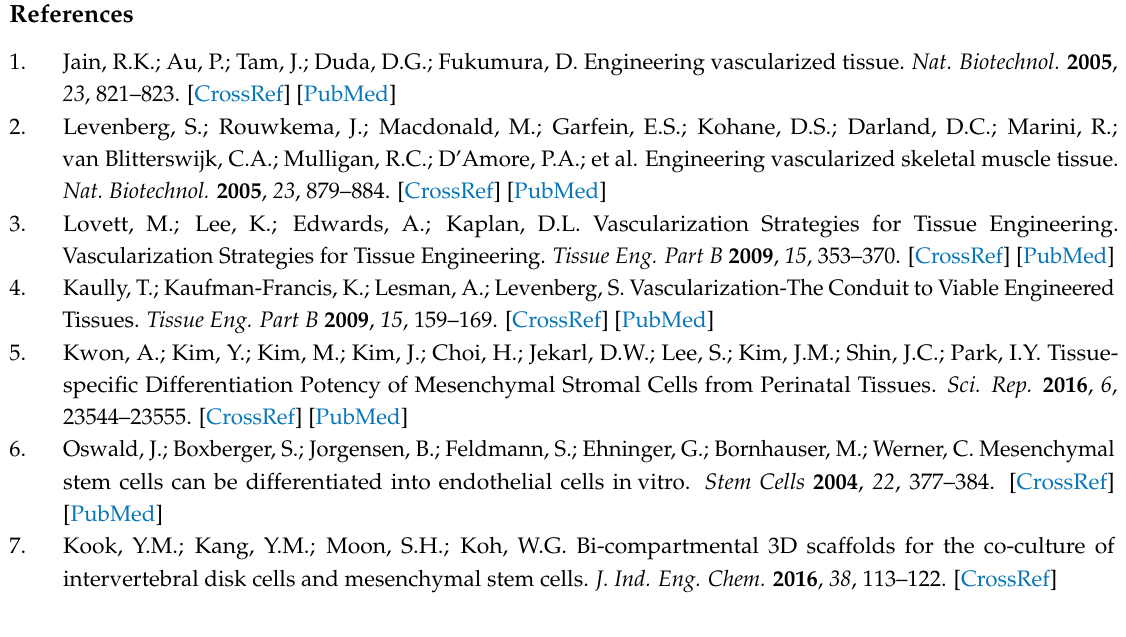
Figure S1: Characterization of isolated hADSCs using flow cytometry. CD44, CD73, CD90, CD105 were labeled as positive markers and CD19, CD45 were labeled as negative